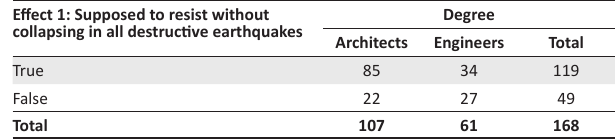
TABLE 11: Effect 1 (resist without collapse).